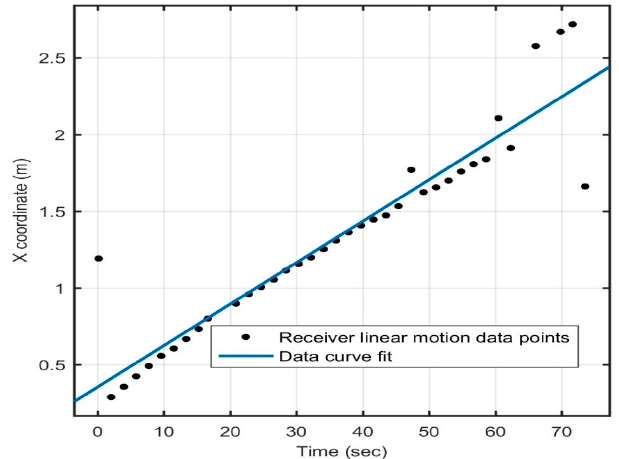
Figure 13. Straight line motion.